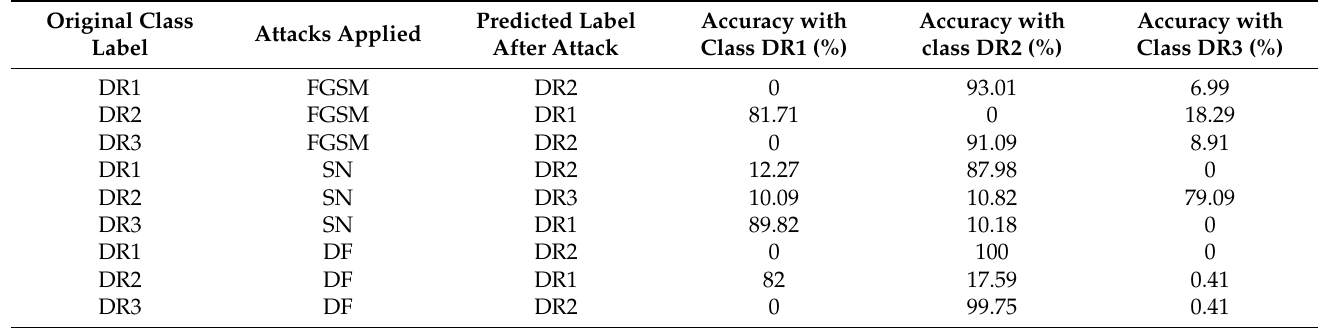
Table 2. Testing of Original Training Network with Attack